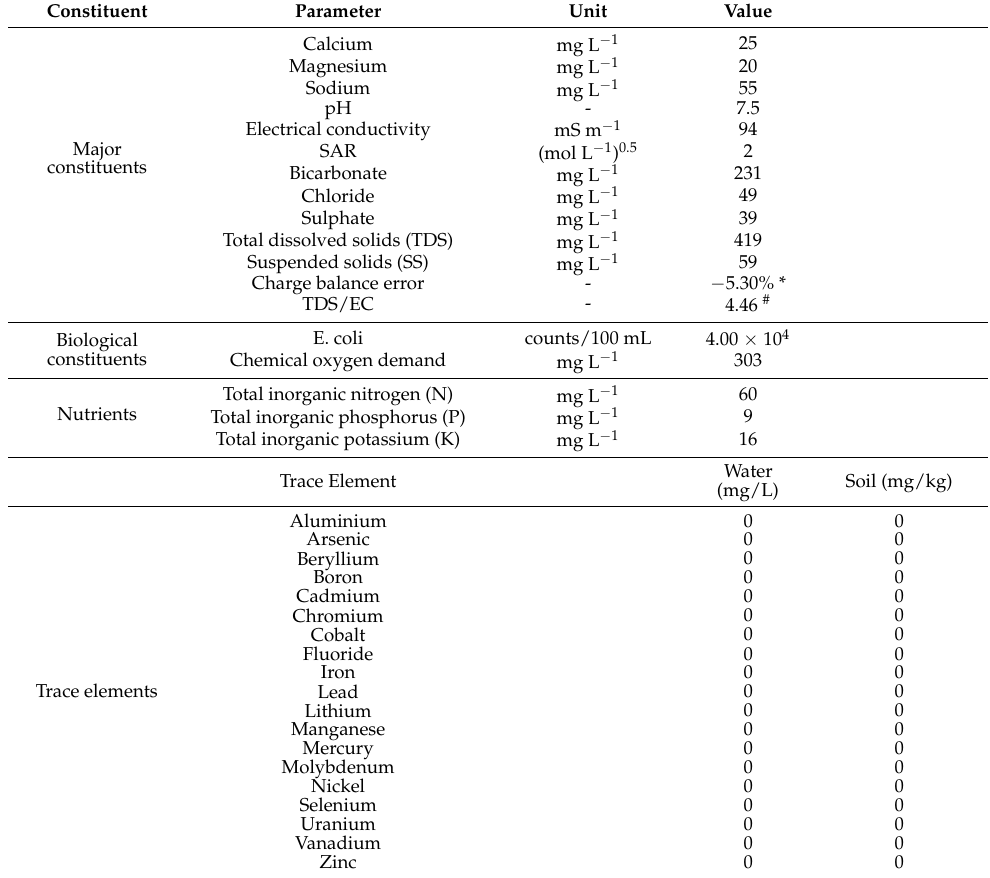
Table 4. The DEWATS effluent showing fitness for agricultural use as determined by the Decision Support